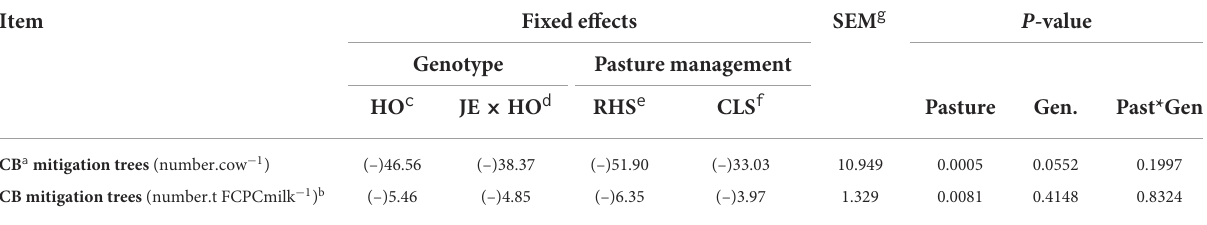
TABLE 7 Trees needed to mitigate GHG emissions for two cow genotypes and two levels of intensification in grazing systems considering the systems carbon